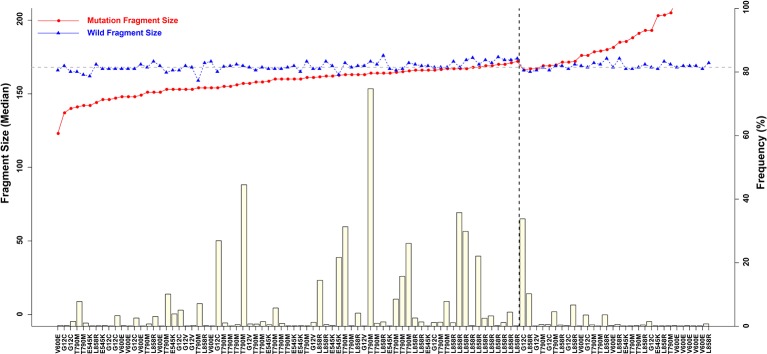
Associations between mutant allele frequency and ctDNA fragment sizes. Gray horizontal dotted line is 168 bp, and black vertical dotted line is L858R.)